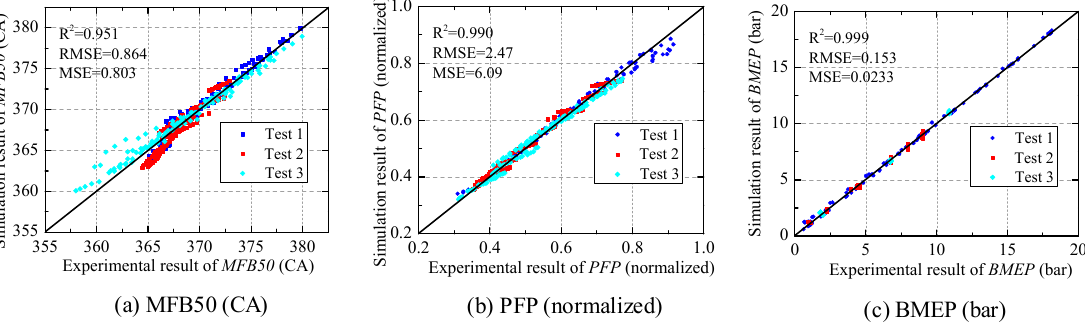
Figure 4. Predicted vs. experimental values of MFB50, PFP and BMEP for the original physics-based model [12], considering the steady-state conditions.